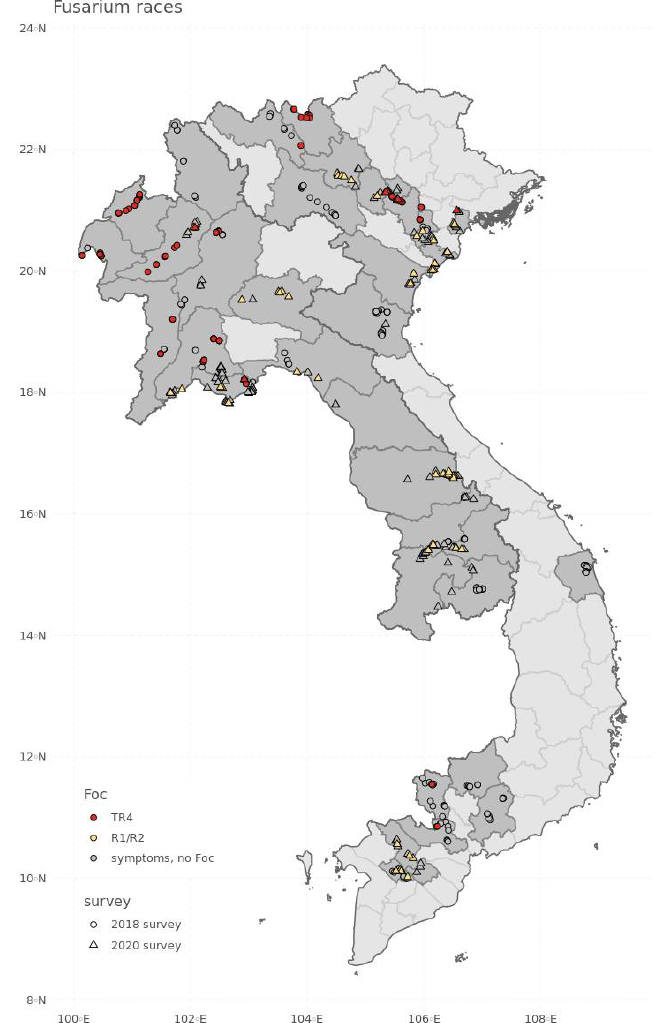
Figure 2. Observations of Fusarium oxysporum f. sp. cubense (Foc) TR4 and Foc R1/R2. Fields surveyed in 2018 are indicated as circles, whereas fields surveyed in 2020 are marked as triangles. Grey points show fields with banana plants showing the traditional symptoms of wilt, but were not identified as fusarium; red points denote sites where Foc TR4 was positively identified; yellow points indicate sites where Foc R1/R2 was positively identified.